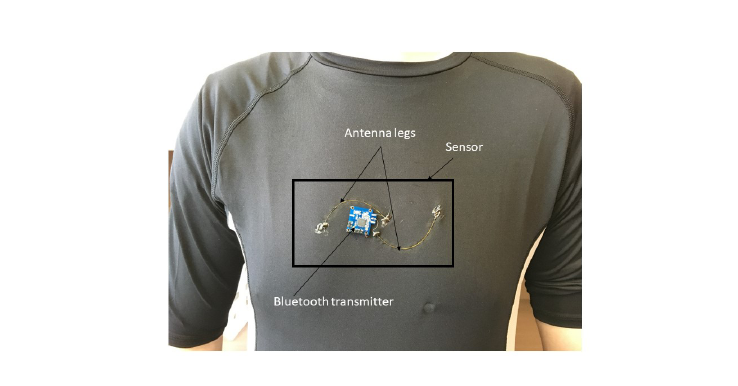
Figure 2. Prototype of the breath sensor made from a polyimide-coated hollow-core silica fiber antenna connected to a Bluetooth transmitter and integrated into a stretchable